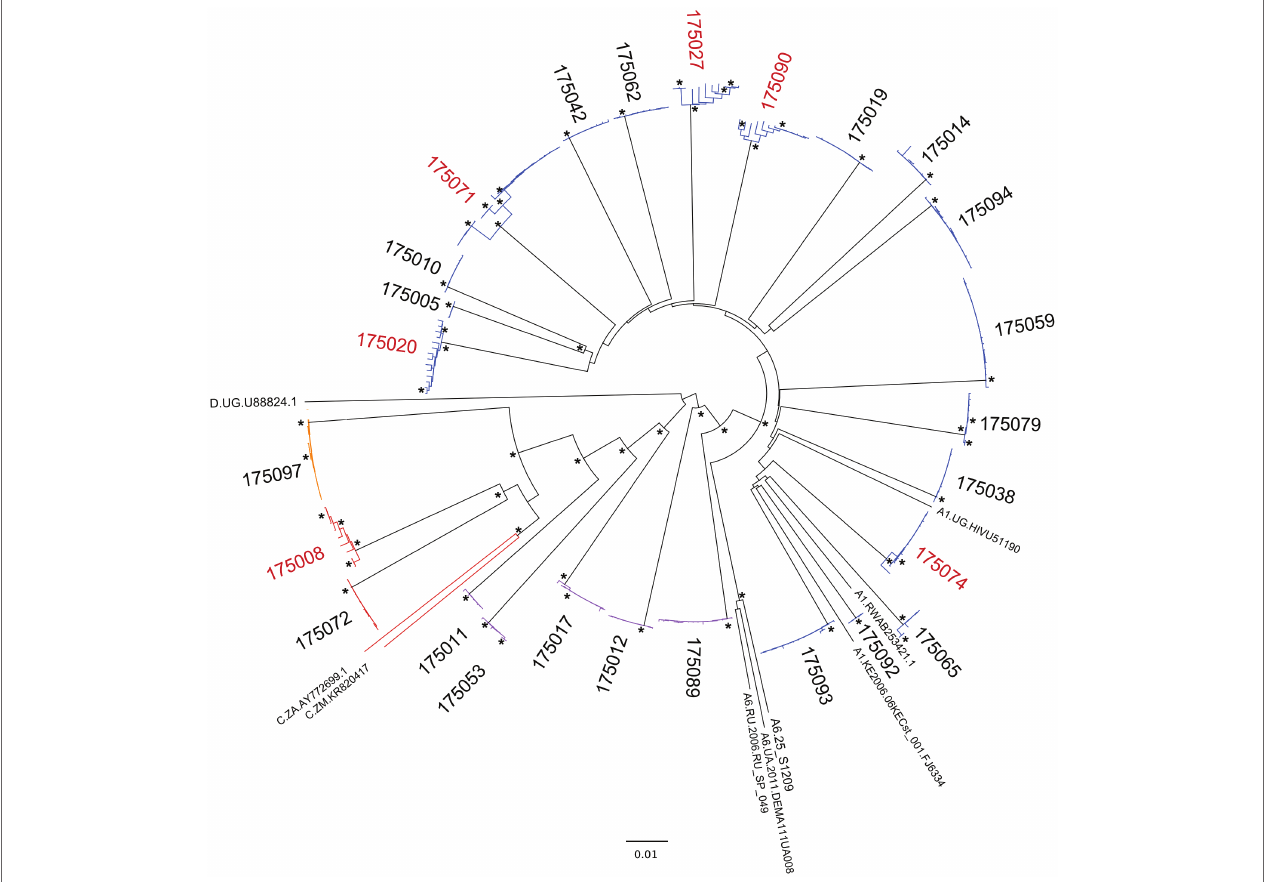
FIGURE 1 | Phylogenetic analysis of virus sequences from Protocol C acute infections. Neighbor-joining tree representing the near full-length genome (NFLG) sequences of viruses from 26 acutely infected recipients with reference subtypes A1, A6, C, and D. Subtype and recombinants are indicated with specific colors (Subtype A, Blue; Subtype C, Red; Recombinant AC, Purple; Recombinant CD, Orange). The IDs of subjects infected with more than one viral variant from their partner are highlighted in red. Nodes with bootstrap values > 0.9 are denoted with an